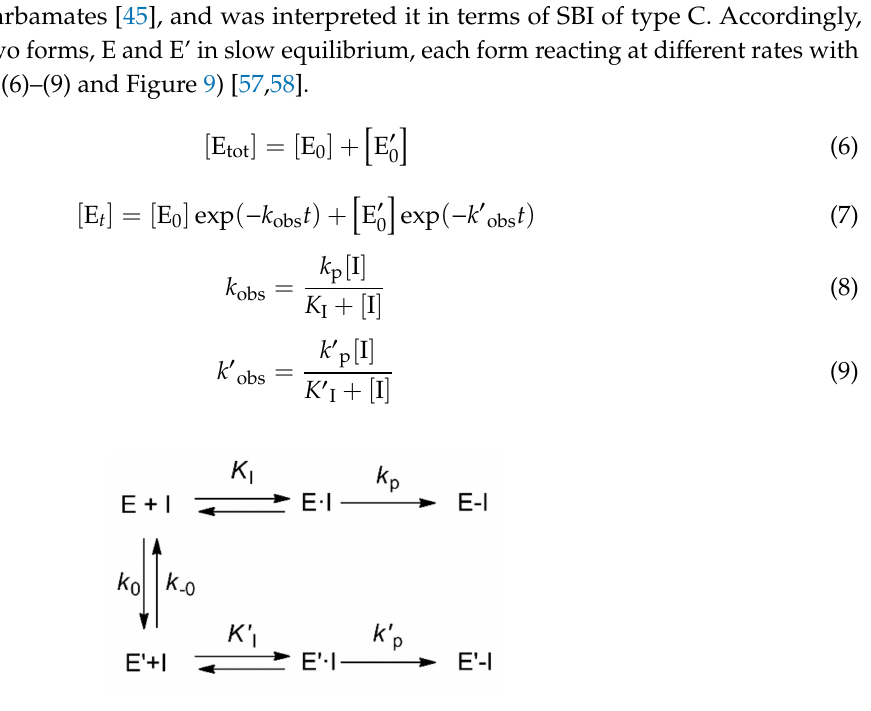
Figure 9. Slow-binding inhibition of type C with a subsequent covalent step, enzyme phosphorylation ( k p ) in the present